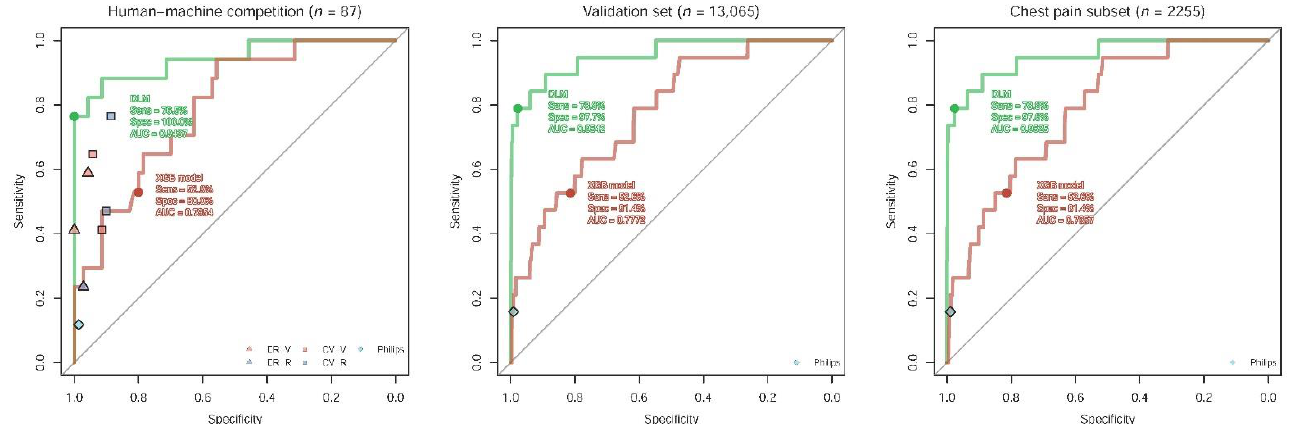
Figure 1. Summary of model performance as the area under the receiver operating characteristic curve for predicting pericarditis. The ROC curves were made by the predictions of the deep learning model (DLM) using raw ECG signals and the XGB model integrating ECG measures (8 numerical values and 31 diagnostic labels), respectively. Each point represents the performance of humans and Philips automatic ECG interpretation. The cut points of the DLM and XGB model were based on Youden’s index in the tuning set .